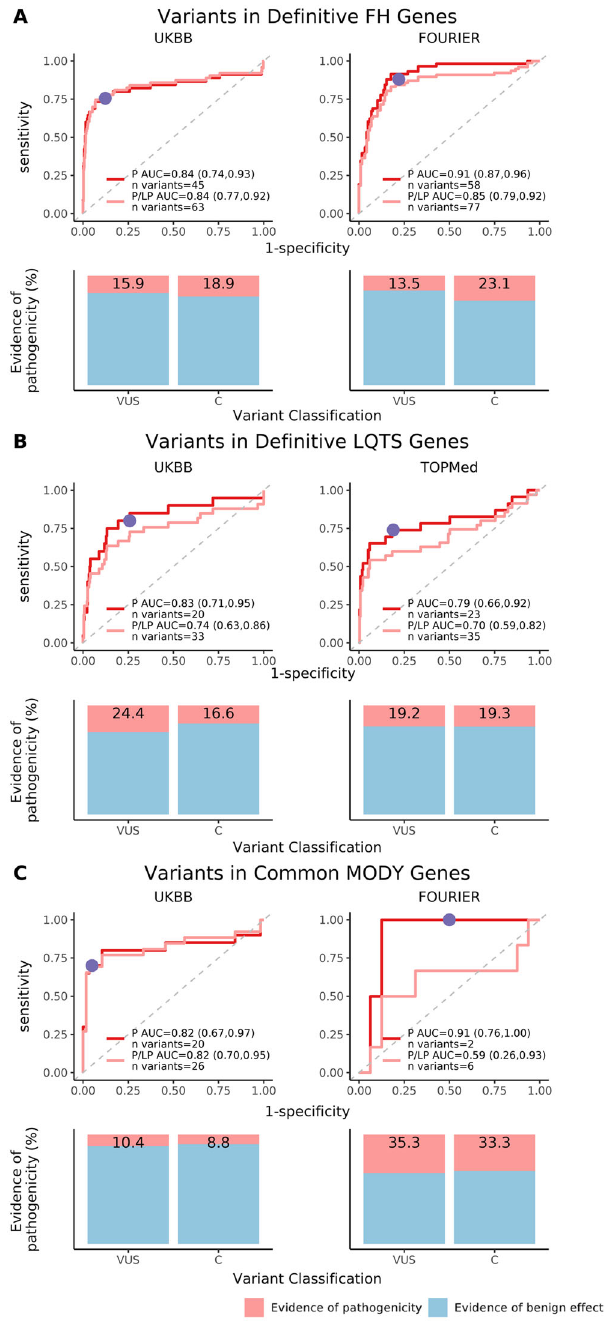
Fig. 2 | Discrimination of variant pathogenicity by effect size and percent of variants with evidence of pathogenicity. A This includes variants within familial hypercholesterolemia (FH) genes recommended for secondary fi ndings return ( LDLR, APOB, PCSK9 ); B includes variants within the long-QT syndrome (LQTS) genes recommended for which the return of a secondary variant fi nding is endorsed ( KCNQ1, KCNH2, SCN5A) ; C includes variants within common maturity- onsetdiabetesoftheyoung(MODY)genes( HNF1A,HNF1B,HNF4A,GCK ).Column1 includes variants from the UK Biobank, the primary cohort; Column 2 includes variants from FOURIER and TOPMed, the replication cohorts. Rows 1, 3, and 5 display receiver operating characteristic (ROC) curves depicting discrimination of pathogenic variants according to effect size. Variant pathogenicity is taken from ClinVar.The red curve includes “ Pathogenic ” variants only;the pinkcurve includes “ Pathogenic ” and “ Likely pathogenic ” variants combined; area under the curve (AUC) values and variant numbers are reported in the legend. Large effect size, de fi ned as effect size greater than 0.5 standard deviations (SD) of the trait dis- tribution,isplottedinpurpleonthe “ Pathogenic ” variantROCcurve.Rows2,4,and 6 display variants by ClinVar category and shows the percent of variants with evidenceforpathogenicityusingthelargeeffectsizethresholdde fi nedinRows1,3, and5.Variantswithevidenceforpathogenicity,de fi nedashavinglargereffectsizes thanthethreshold,areinpink;variantswithevidenceforabenigneffect,de fi nedas having smaller effect sizes than the threshold, are in light